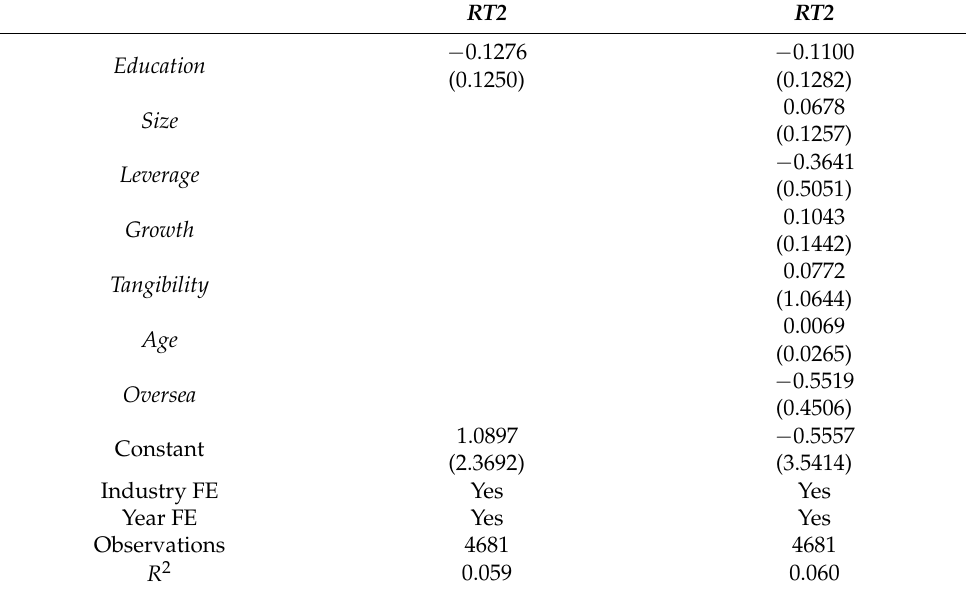
Table 8. Alternative risk-taking measures using ROE.